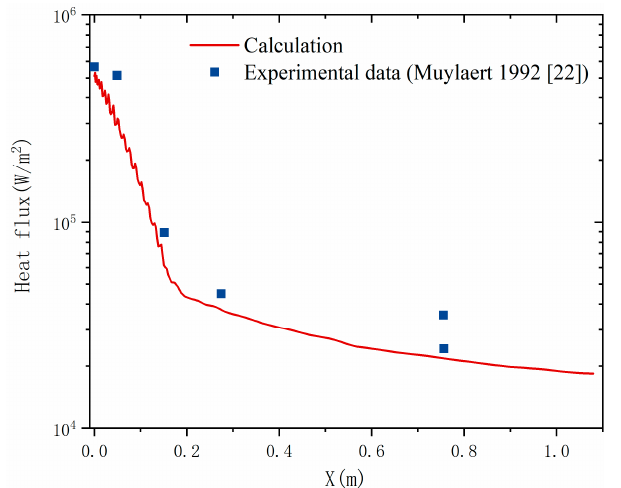
Figure 2. Comparison of heat flux obtained from the calculation and experiment.